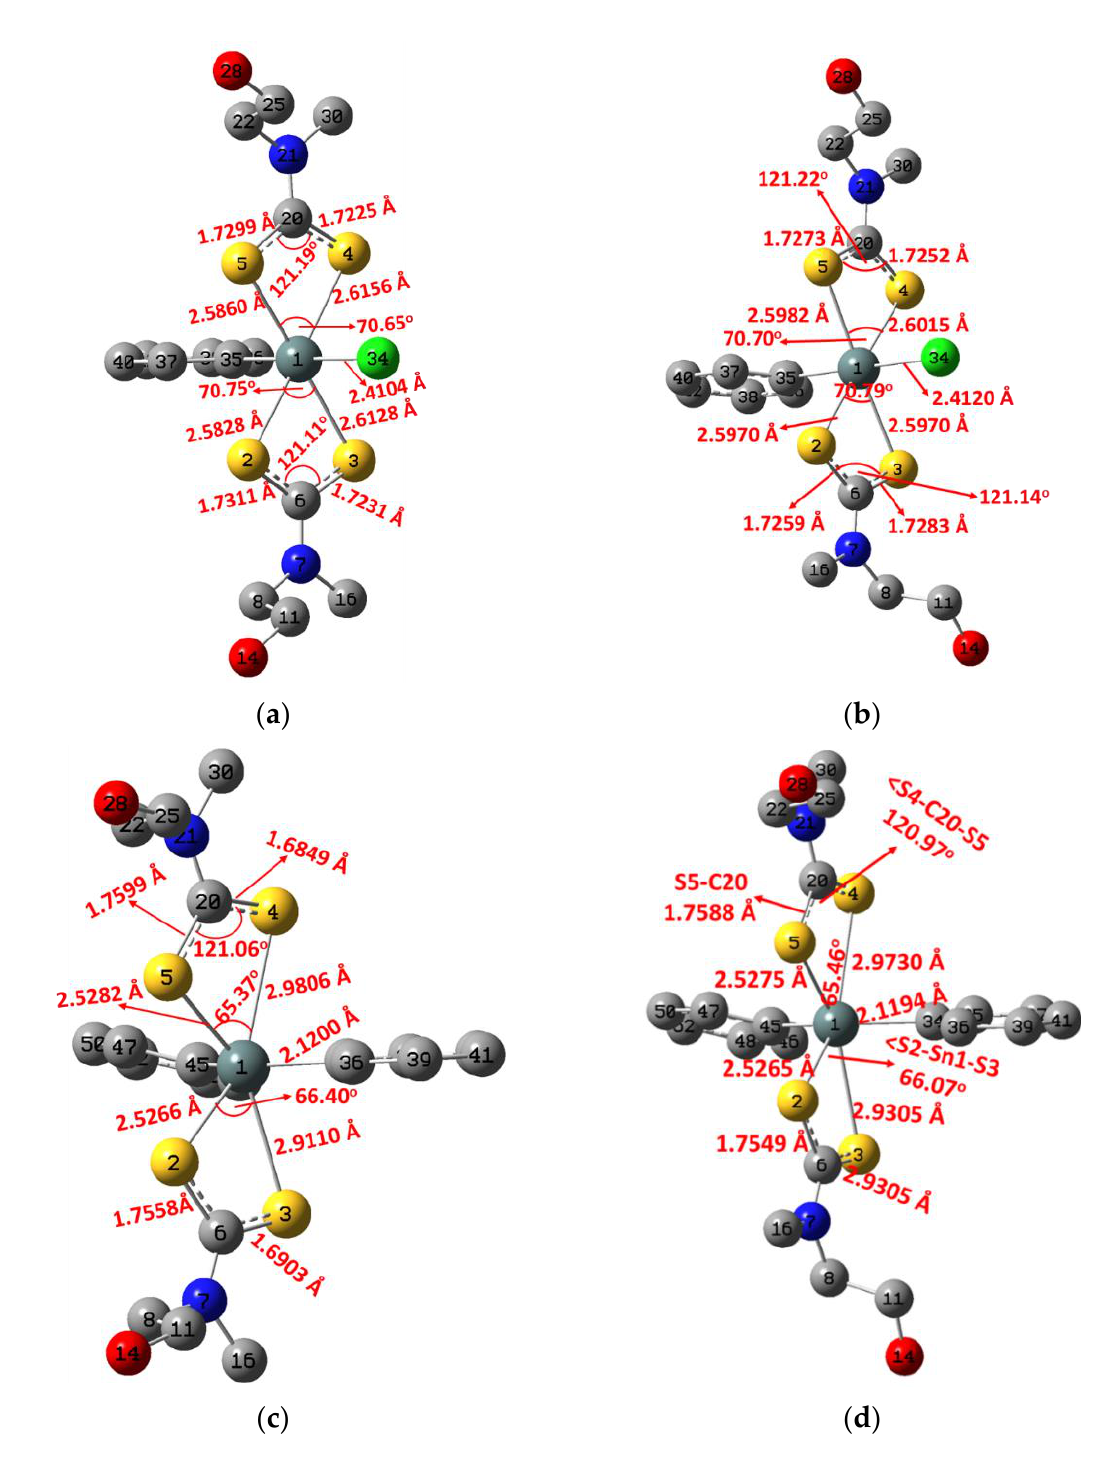
Figure 1. Optimized ground state equilibrium structures of ( a ) syn-syn conformation of [(C 6 H 5 )(Cl)Sn(L) 2 ], ( b ) anti-anti conformation of [(C 6 H 5 )(Cl)Sn(L) 2 ], ( c ) syn-syn conformation of [(C6H5)2Sn(L)2] , and ( d ) anti-anti conformation of [(C6H5)2Sn(L)2], obtained at M06/cc- TVPZ//LANL2DZ level.